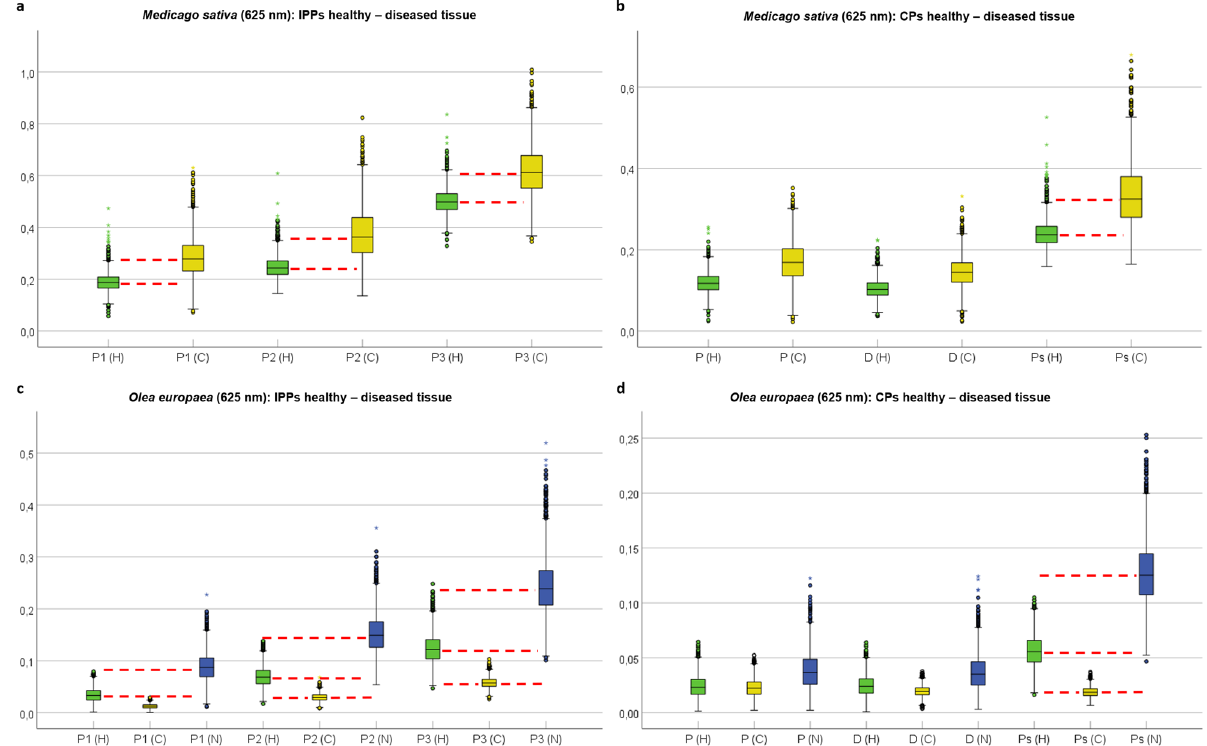
Figure 5. Boxplot charts for healthy and diseased regions for Medicago sativa and Olea europaea . ( a ) Indices of polarimetric purity ( P 1 , P 2 , P 3 ) boxplot for healthy and chlorotic locations on M. sativa , ( b ) Components of purity ( P , D , P S ) Boxplot for healthy and chlorotic locations on M. sativa , ( c ) Indices of polarimetric purity ( P 1 , P 2 , P 3 ) Boxplot for healthy, necrotic and chlorotic locations on O. europaea and ( d ) Purity components ( P , D , P S ) Boxplot for healthy, necrotic and chlorotic locations on O. europaea. The corresponding healthy, chlorotic and necrotic data distributions are labeled and colored as H (green), C (yellow) and N (dark blue), respectively. Red- dashed lines indicate the locations of median values and illustrate they do not fit within the boxes of different tissue conditions (healthy, chlorotic or necrotic), allowing discrimination. Circles and stars correspond to mild and extreme outlier values, respectively.